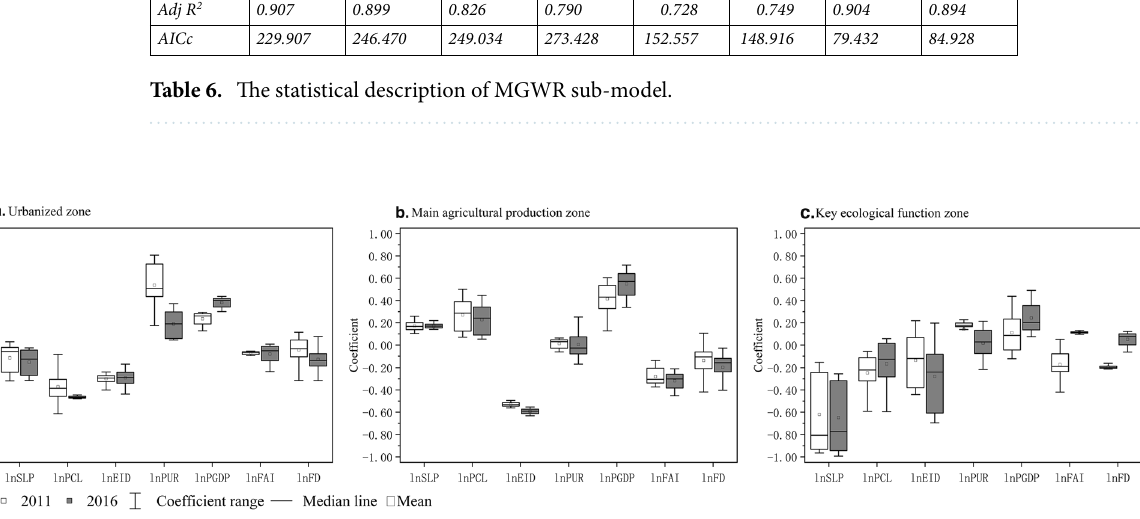
Figure 7. Regression coefficients in MGWR of major functional zones. ( a ) Urbanized zone. ( b ) Main agricultural production zone. ( c ) Key ecological function zone. Software: Origin 2018. URL: https:// www. origi nlab.